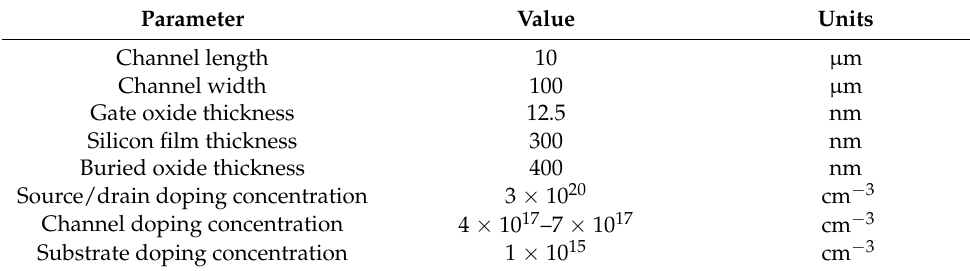
Figure 4. 180nm H − gate silicon on insulator (SOI) N-type MOSFET simulation model. ( a ) 3 − D structure ( b ) 2 − D cross − sec- Figure 4. 180 nm H-gate silicon on insulator (SOI) N-type MOSFET simulation model. ( a ) 3-D structure ( b ) 2-D cross-section tion view cut along the A − A’ direction. view cut along the A-A’ direction. Table 1. Structure and process parameters in the simulation devices. Table 1. Structure and process parameters in the simulation